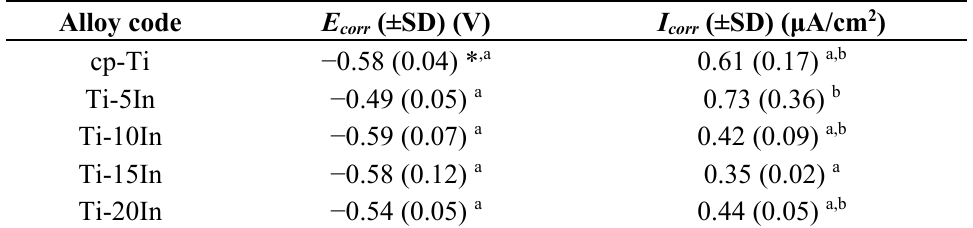
Figure 9. Representative potentiodynamic polarization curves for cp-Ti and Ti- x In alloys. The arrows indicate the critical potential. Table 2. Corrosion potential ( E corr ) and corrosion current density ( I corr ) of cp-Ti and Ti- x In